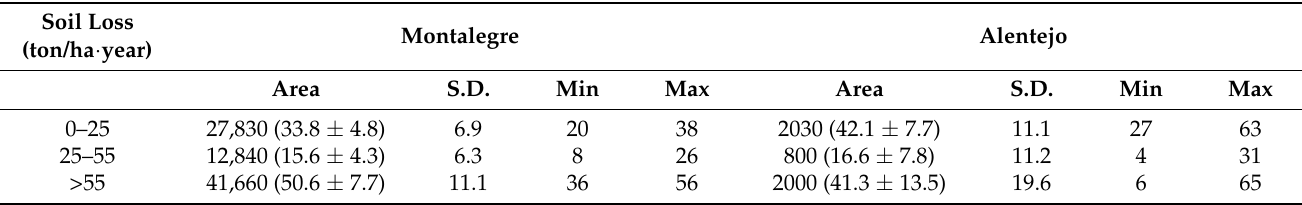
Table 4. Statistical variables for the three levels (0–25, 25–55 and >55 ton/ha · year) including: the total area value (in ha) followed by the percentage area ± confidence interval, the standard deviation, minimum value, and maximum value, for each region, Montalegre and